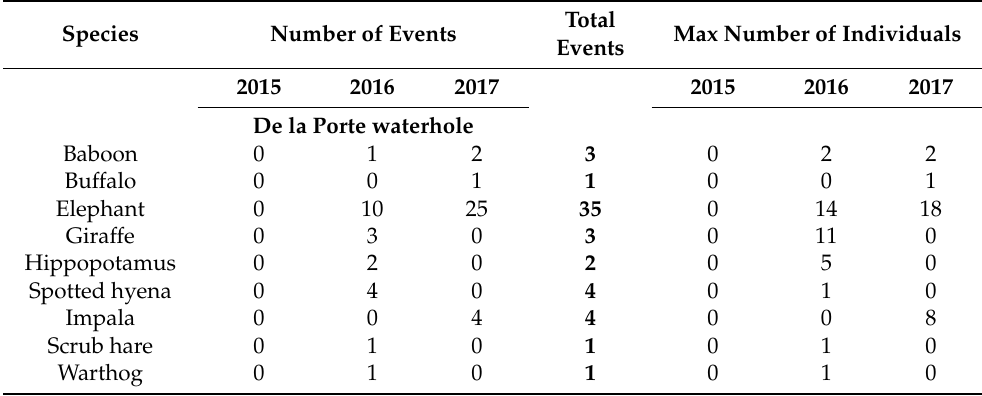
Figure 1. Mammal species (excluding rhino species) present in different zones during three survey periods: ( a ) catenal zones; ( b ) mud wallows, waterholes and ( c ) granite-boulder outcrops. The colour gradient is used to indicate number of events (observations) of each species where increasing numbers were represented by darker colours. Table 2. Number of events (observations) of the mammal species (excluding rhinos) and the maxi- mum group size observed at each of the three waterholes during that survey